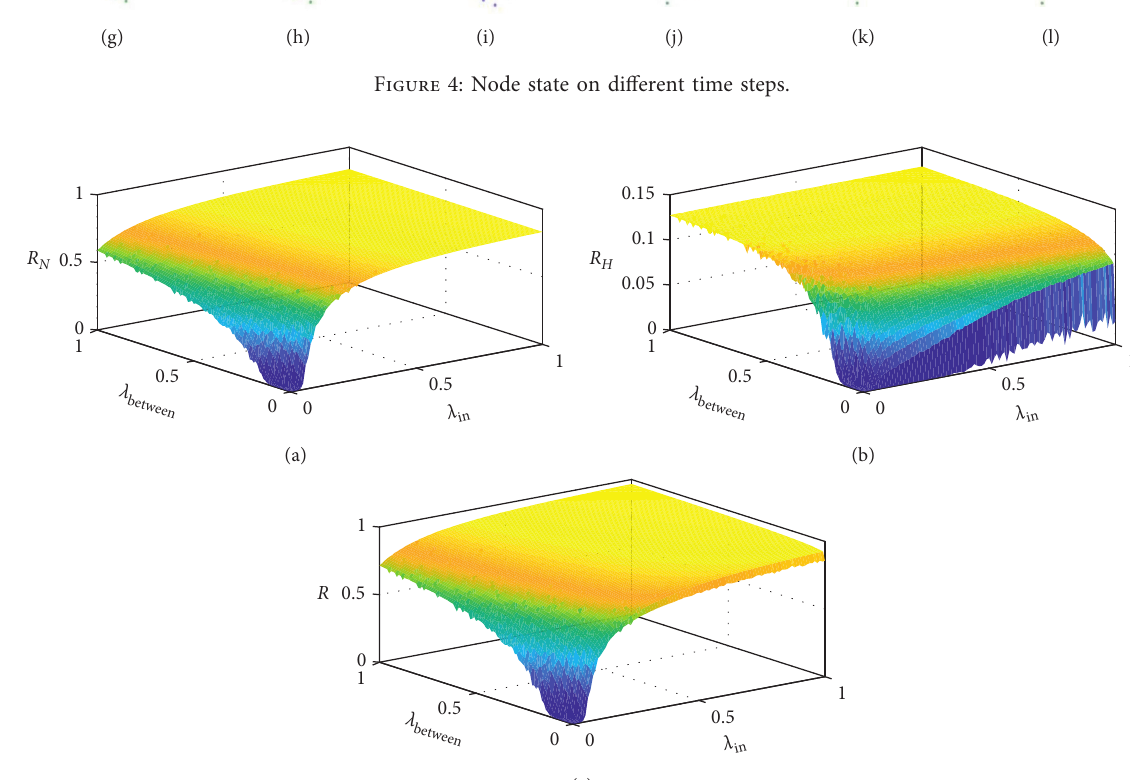
Figure 5: Information spreading on real-world